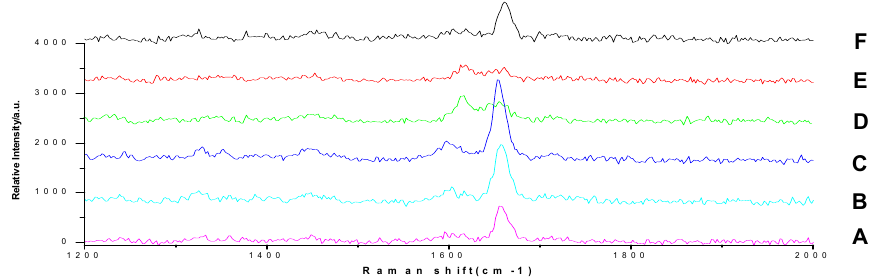
Figure 4. The common structure of steroids. Figure 5. Raman spectra of reference substance solutions by TLC–SCRS (deposition amount of 10 μ g). A , B , C , D , E , F : prednisone, prednisone acetate, prednisolone, hydrocortisone, hydrocortisone acetate, and dexamethasone.